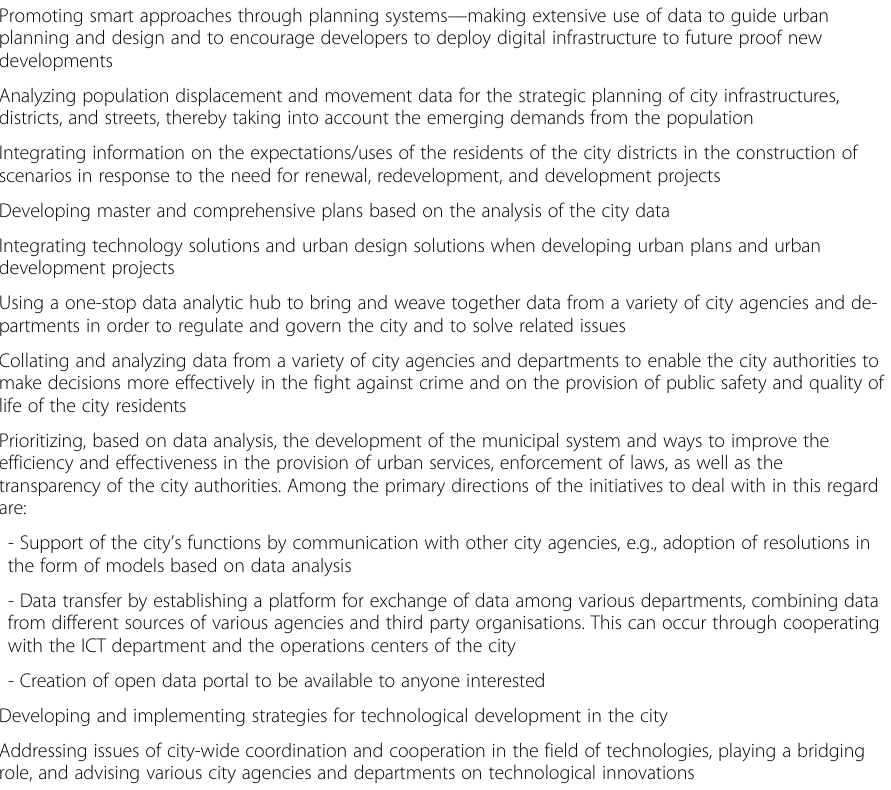
Table 10 The key functions of strategic planning and policy